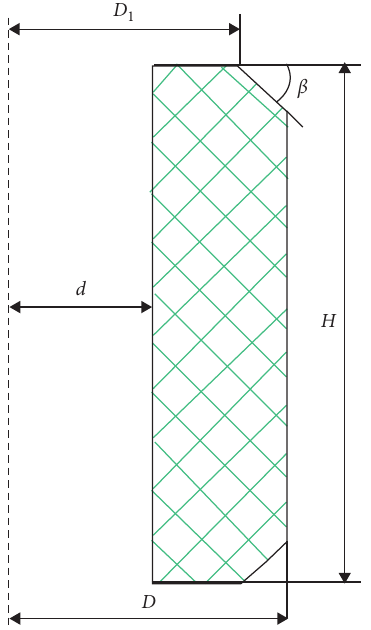
Figure 14: The design size diagram of the rubber